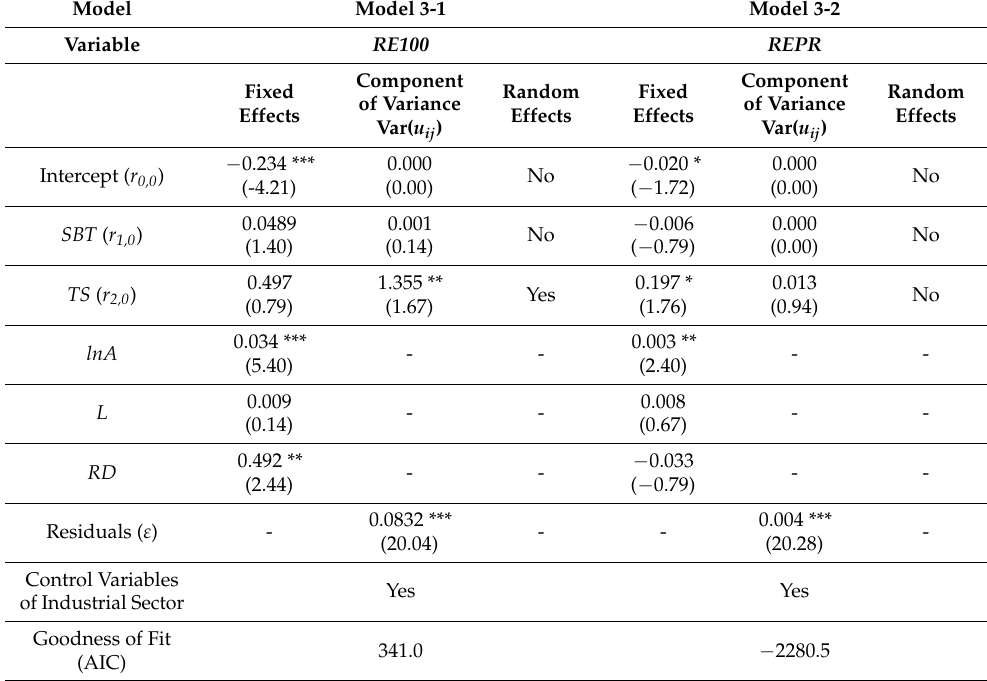
Table 5. The results of random coefficients regression model estimates under the